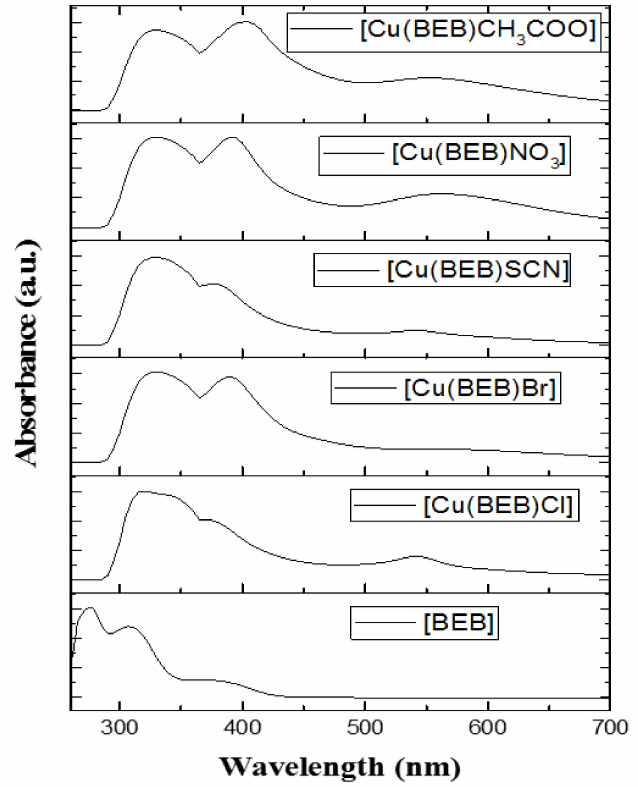
Figure 2. Electronic visible absorption spectra of Cu(II) complexes of Schiff base (BEB) in